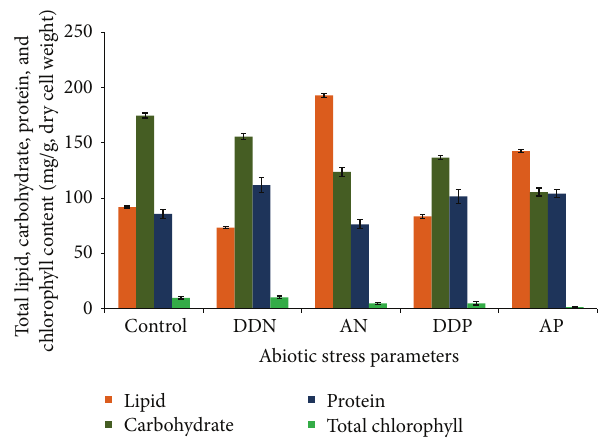
Figure 2: Bar graphs showing total chlorophyll, carbohydrate, protein, and lipid content (mg/g) of both control and treated biomass (DDN, AN, DDP, and AP) in dry weight basis. 𝑃 = probability value (significant level); 𝑃 ≤ 0.05 .